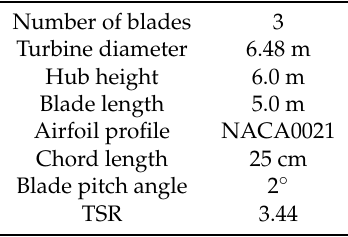
Table 1. Specification of the 12 kW Vertical Axis Wind Turbines (VAWT) used for